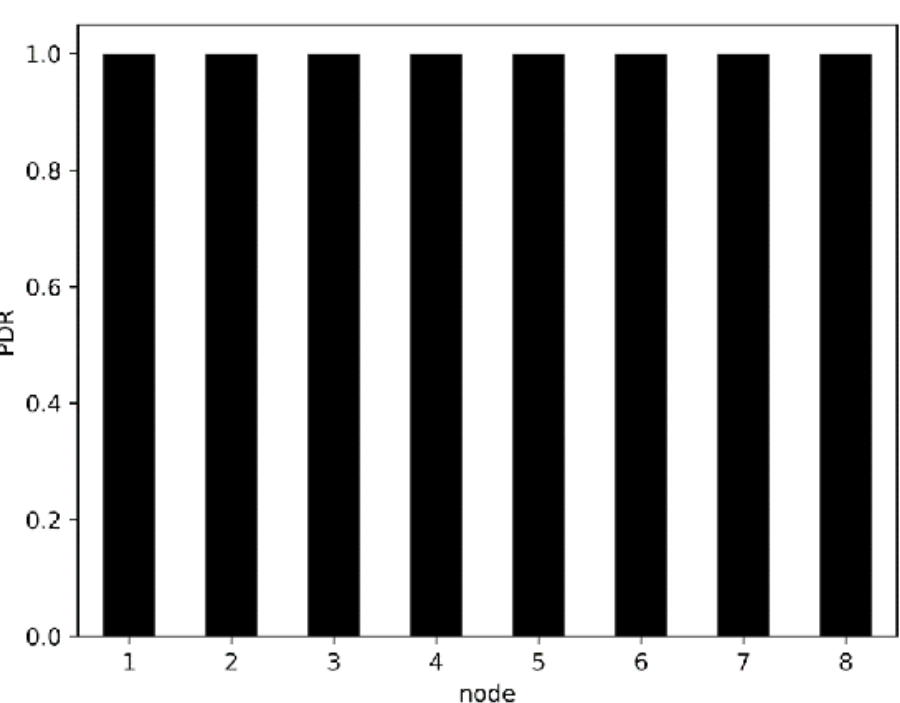
Figure 6. PDR of each node in the proposed method.